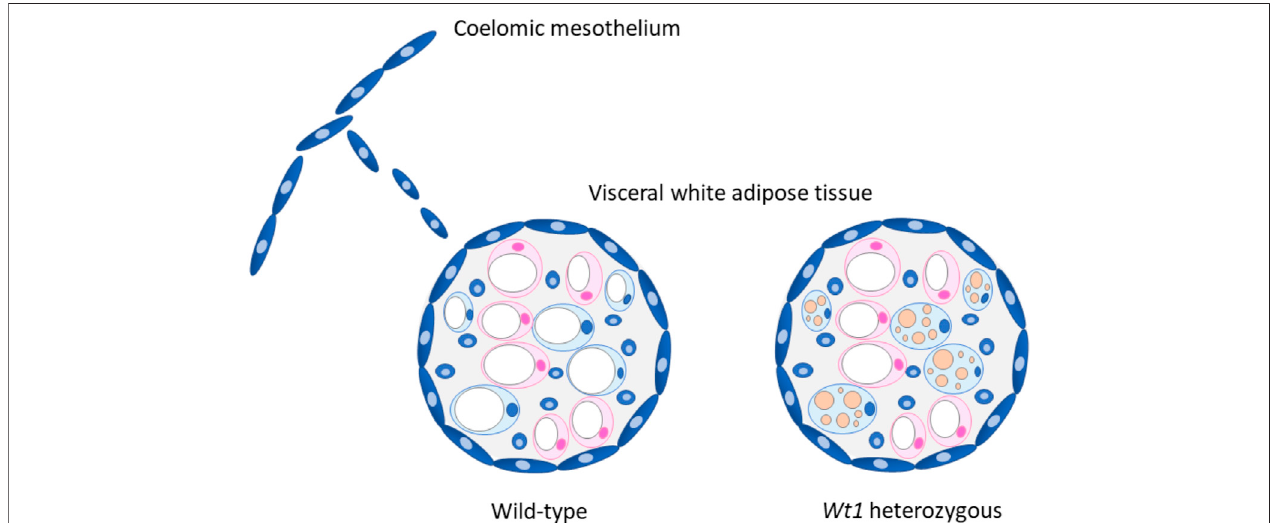
FIGURE1| ProposedroleofWT1invisceralwhiteadiposetissue(WAT).WT1expressingcells(blue)derivedfromthecoelomicmesotheliumpossiblycontributeto thevisceralfatdepots, whicharecoveredwithamesothelialcelllayer.(Chauetal.,2014).Heterozygous Wt1 knockoutmiceshowmorphologicalandmolecularsignsof browningintheirvisceral(epididymal)WAT.(Kirschneretal.,2022).ItiscurrentlyunknownwhetherepididymalWATbrowningisrestrictedtoadipocytesoriginatingfrom WT1 expressing progenitor cells (blue) asdrawnin the fi gure,or also includes WT1-negativecells(pink). The markedmultilocularfat depositionin beige adipocytes is drawn for the sake of clarity but not seen in heterozygous Wt1 knockout mice. (Kirschner et al., 2022). Adapted with modi fi cations from ref. (Chau and Hastie, 2015).